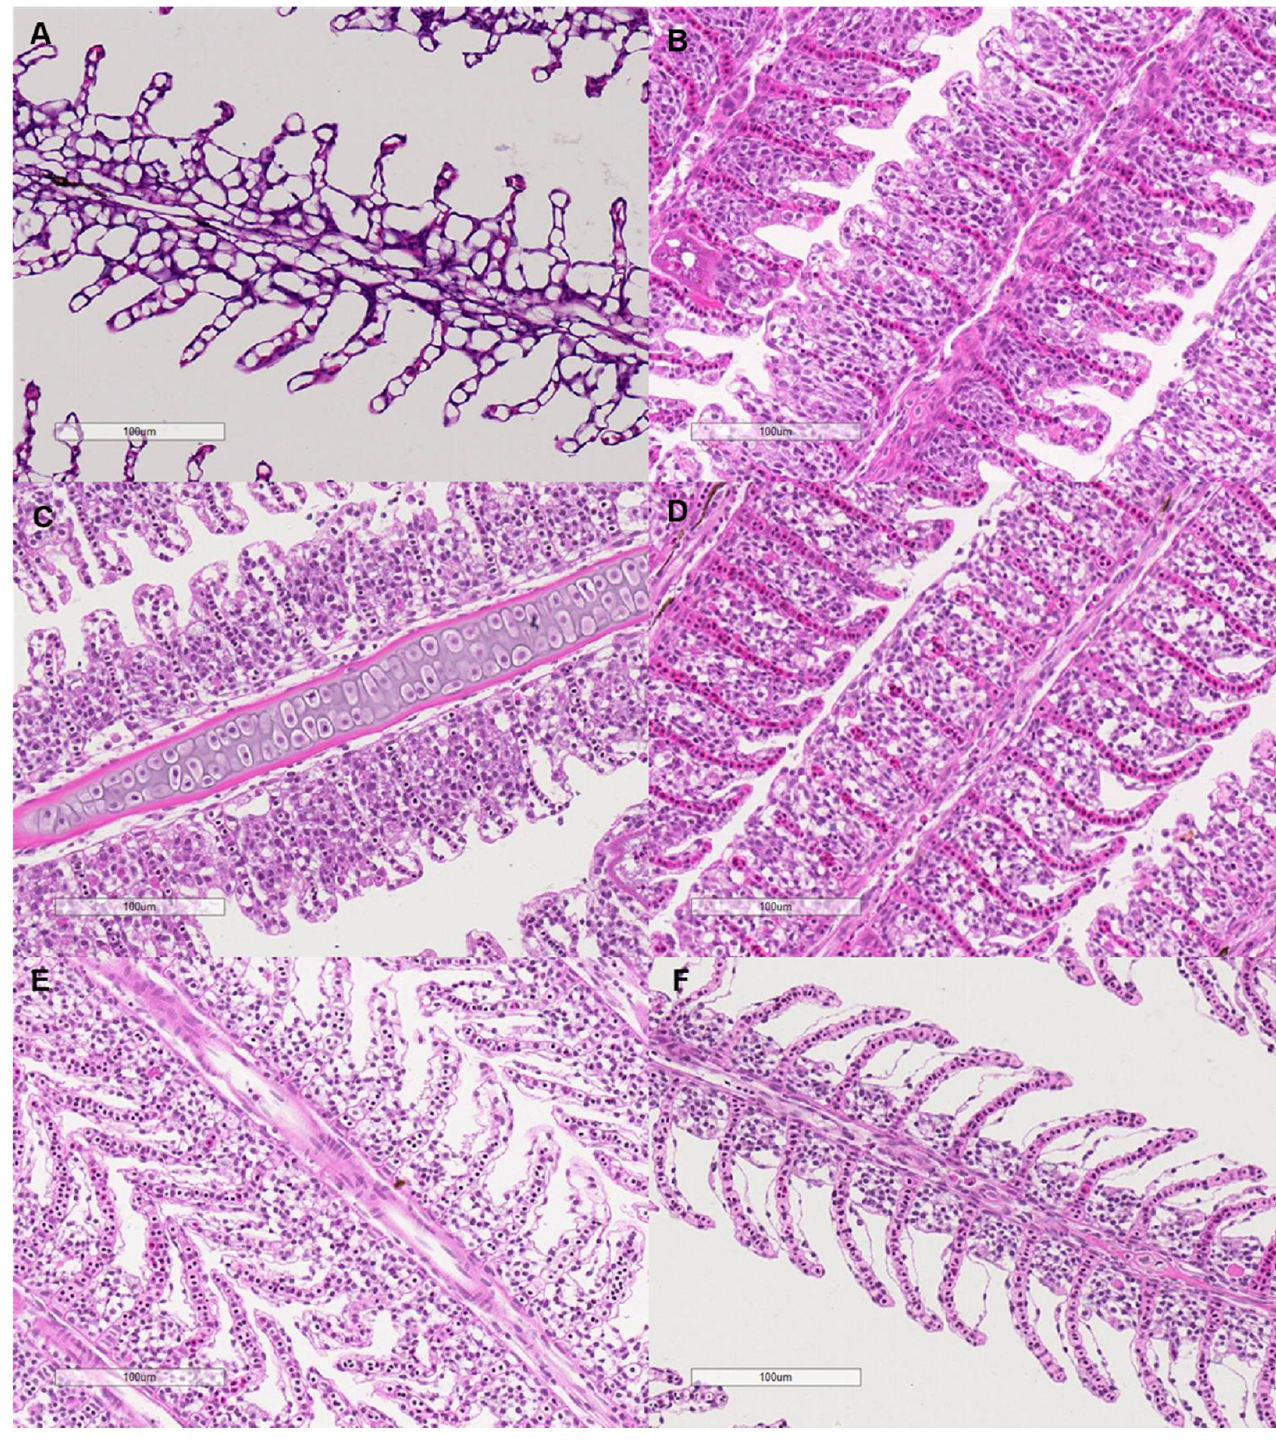
Figure 7. Microscopy of the filament structure of grass carp treated with different salinities (400×). The letters indicate the salinities. ( A ): 0 g kg − 1 ; ( B ): 0.375 g kg − 1 ; ( C ): 0.75 g kg − 1 ; ( D ): 1.5 g kg − 1 ; ( E ): 3 g kg − 1 ; ( F ): 6 g kg − 1 . The bars represent 100 µ m. Salinity induced similar ‘U’-shape changes in the Na + -K + -ATPase activities of the gills ( F = 11.26, p < 0.001) and digestive tract ( F = 11.19, p < 0.001), but not the kidneys (Figure